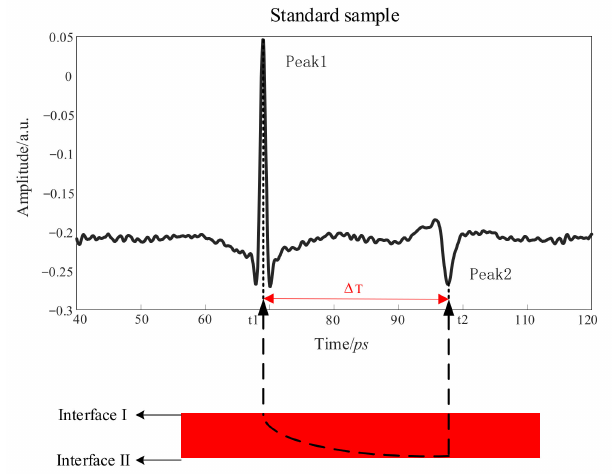
Figure 5. Reflection terahertz time-domain waveform of